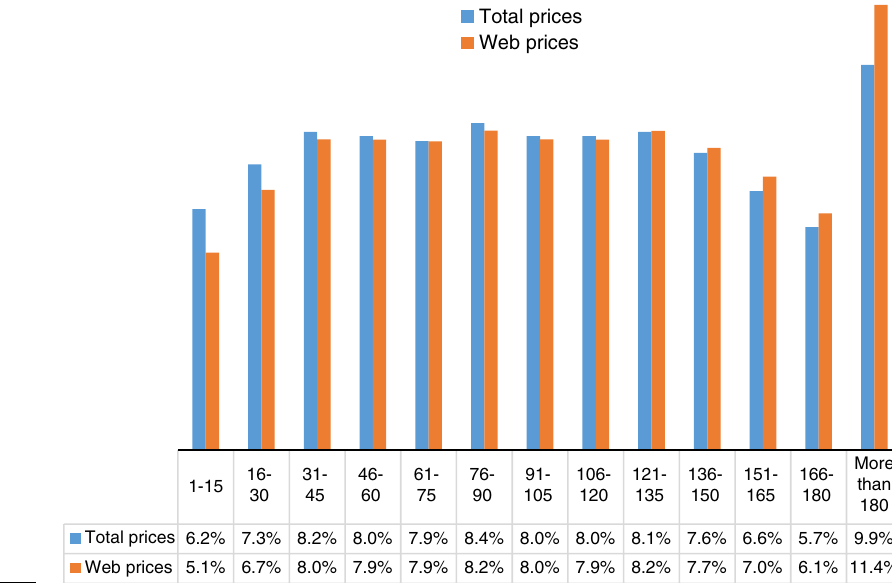
Figure 1. Percentage